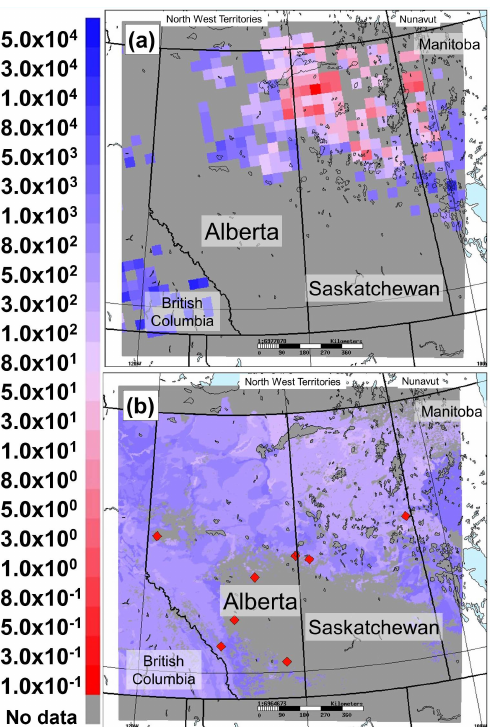
Figure 3. Critical loads of acidity on the 2.5km GEM-MACH domain, based on a Canada-wide implementation: (a) Critical load for acidity (Eq. 5) and (b) forest ecosystems (Eq. 18) (eqha − 1 yr − 1 ). Forest values were calculated using 1994–1998 in- terpolated/extrapolated BC dep observations (diamonds show the lo- cation of those Canada-wide stations used to estimate BC dep , which reside within the 2.5km resolution model domain). Red regions (low numbers) on the scale have the lowest critical loads, hence are the most sensitive to deposition. No data: (a) no lake observations were available in the given 45km × 45km grid cell; (b) No forest data were available and/or the “no data” regions were not